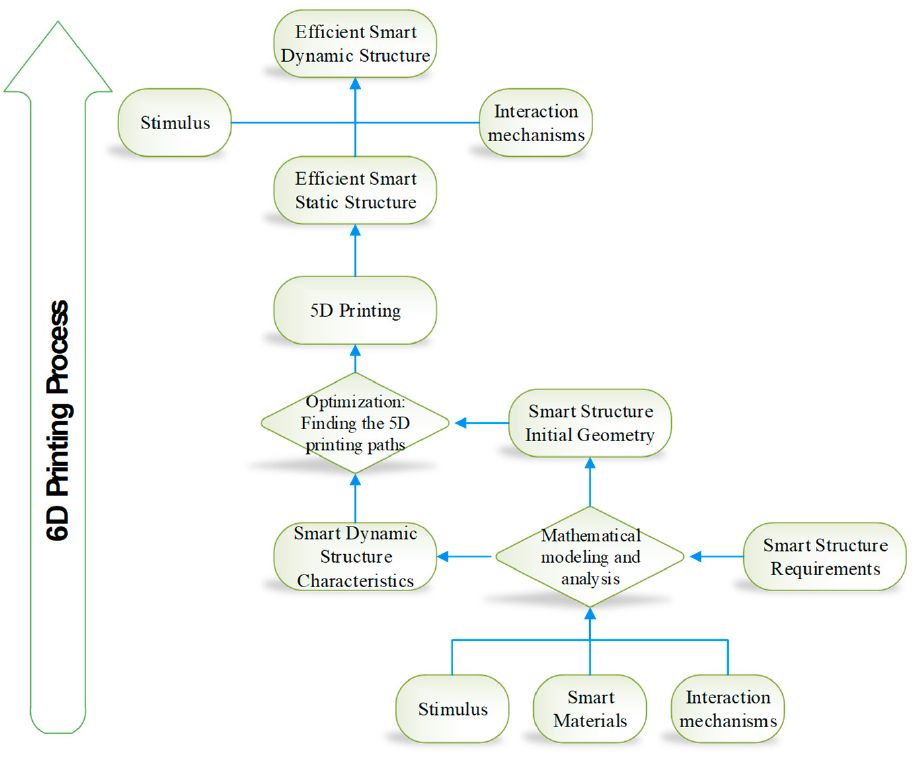
Figure 2. The concept of 6D printing.